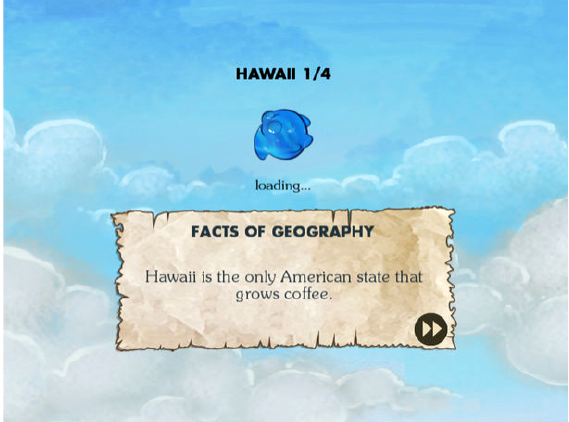
Figure 1. Fact bubbles that appear as players enter a level. 3